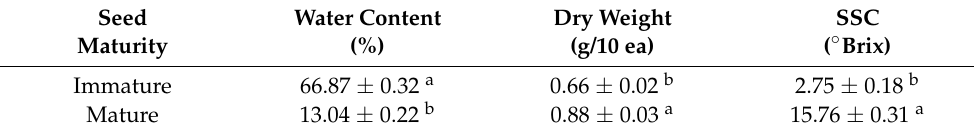
Table 1. Physical characteristics of immature and mature soybean seeds.